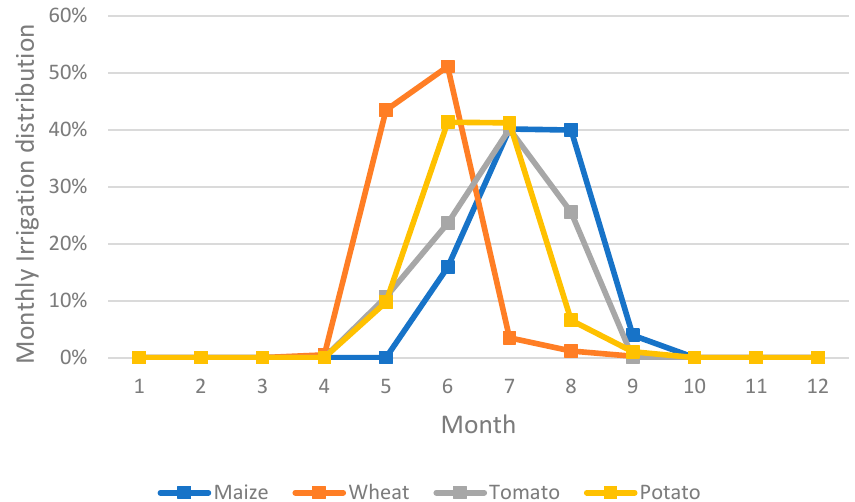
Figure 4. Irrigation distribution of the four main crops of the dataset.